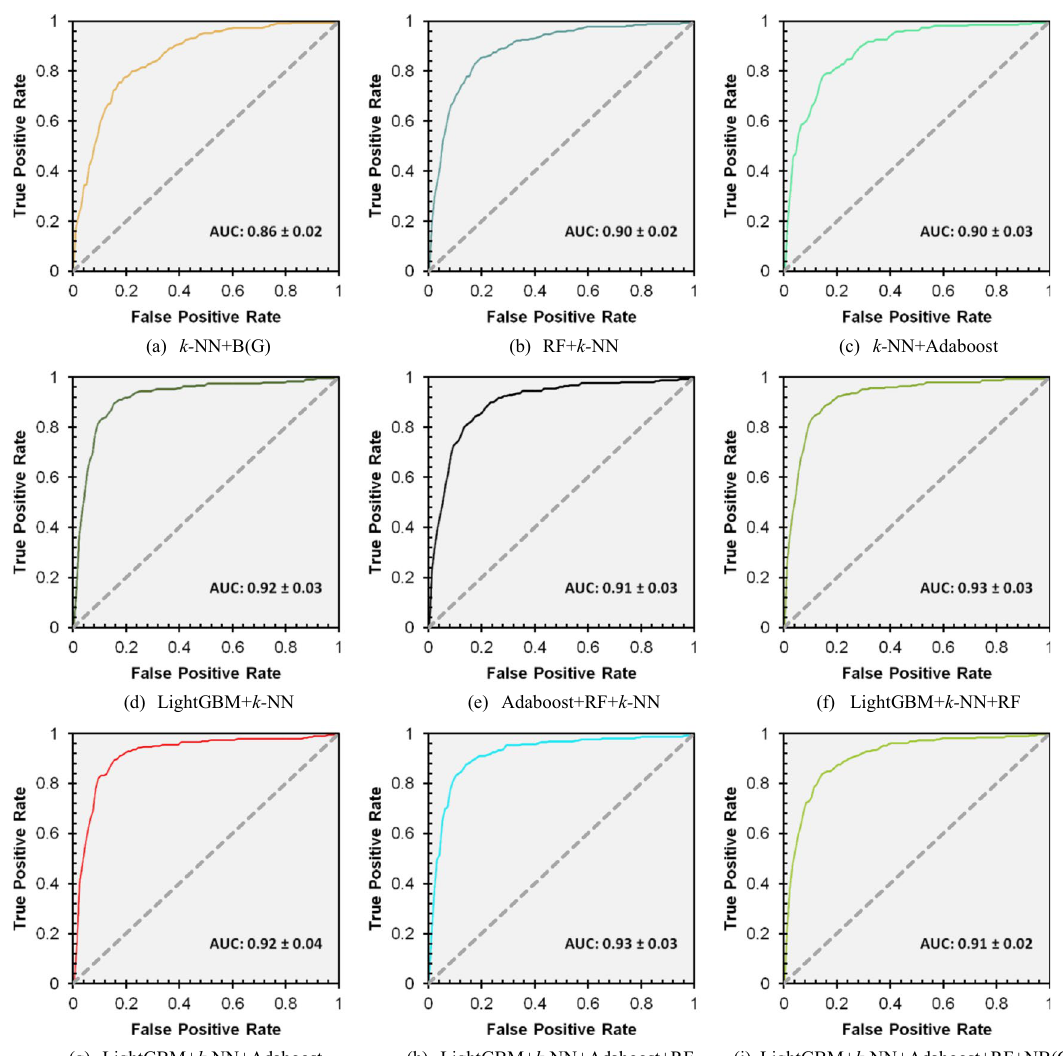
Fig. 3 ROC curve of various hybrid ensemble models along with the proposed ensemble